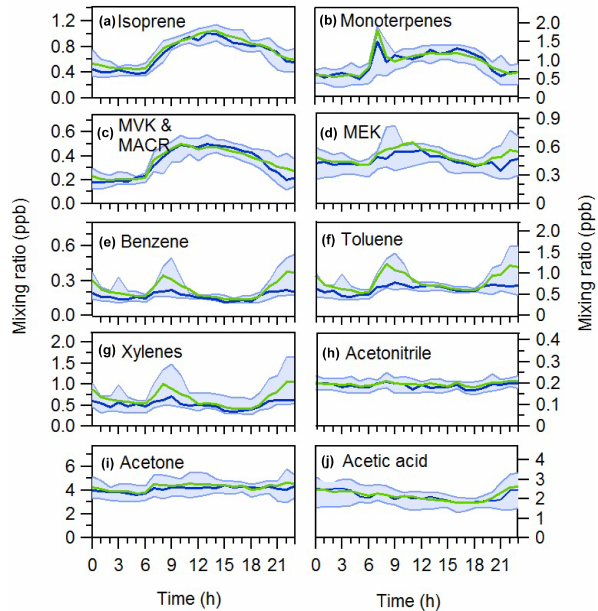
Figure 3. Average VOC diurnal profiles during the Athens summer campaign. Green lines present the average values. The median value is shown with blue. The blue area corresponds to the interquartile range.